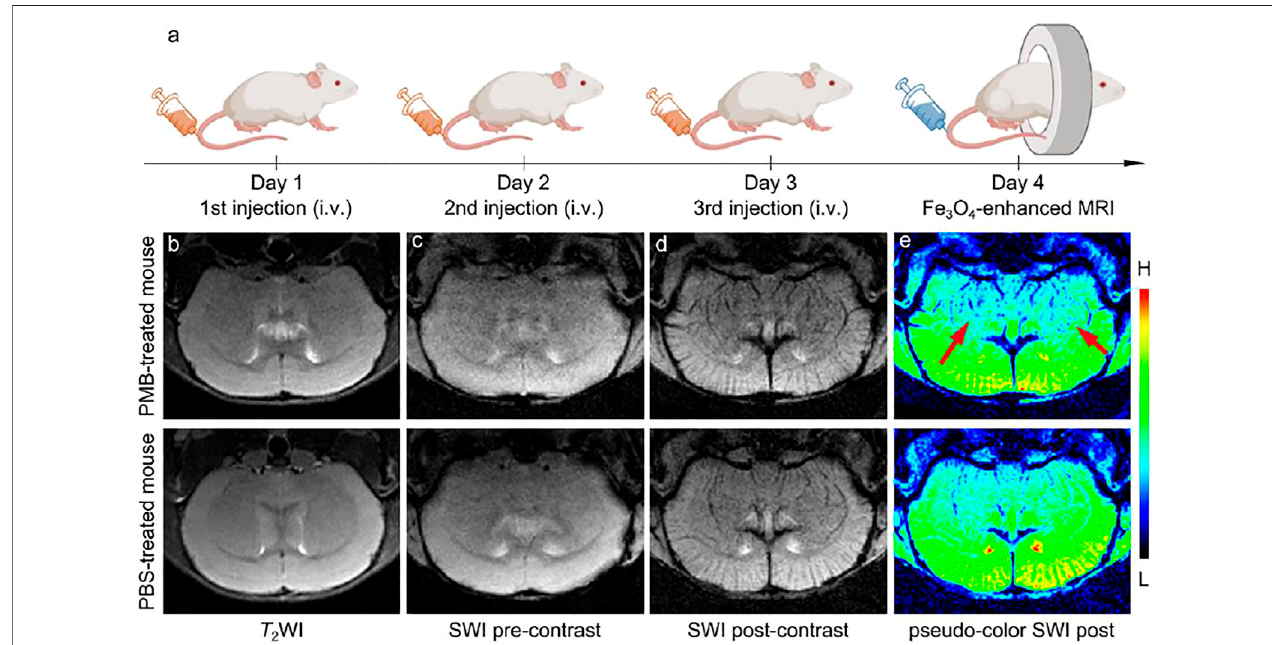
FIGURE3|(a) SchematicillustrationofinjectionprocedureofthePBSorPMB,thenanoparticlesadministrationmodalities,andbrainMRimaging. (b) T 2 -weighted imaging of the brain of PBS- or PMB-treated mice, respectively, before injecting the Fe 3 O 4 nanoparticles. SWI of the brain of PBS- or PMB-treated mice, respectively, before (c) and after (d) injecting the Fe 3 O 4 nanoparticles, together with the SW images in (d) with pseudocolor (e)